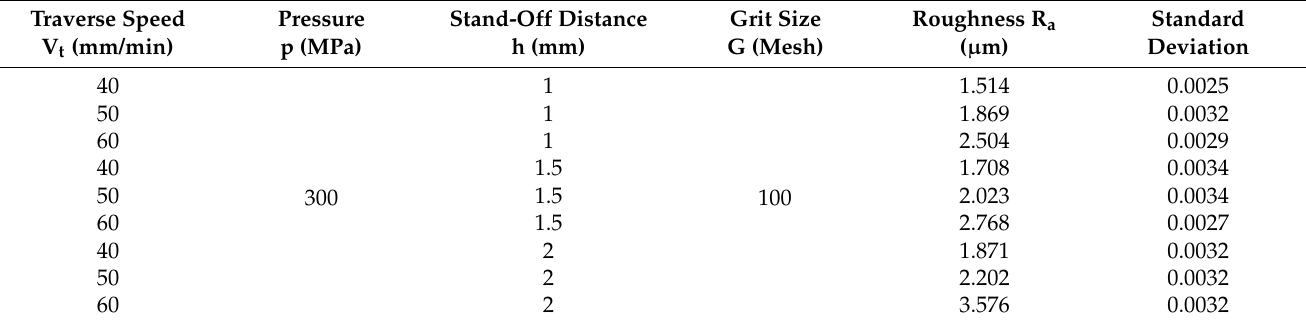
Table 3. Roughness values obtained upon adjusting traverse speed and stand-off distance. Traverse